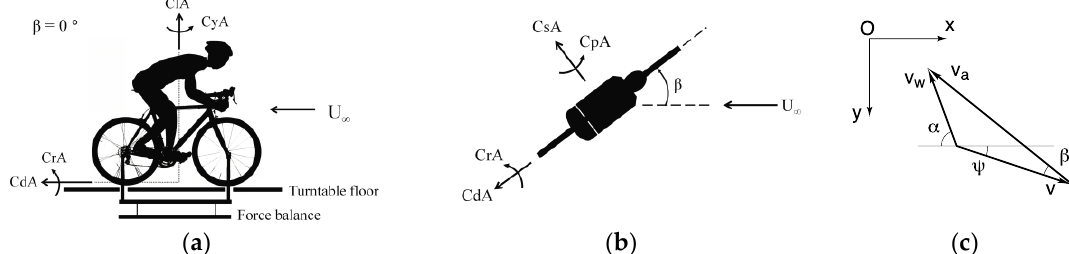
Figure 2. Bicycle and rider system subjected to cross wind together with the definition of the various aerodynamic force and moment coefficients and apparent wind speed, in ( a ) side view; and ( b ) top view, with drag force coefficient CdA , lift force coefficient ClA , side force coefficient CsA , roll moment coefficient CrA , pitch moment coefficient CpA , and yaw moment coefficient CyA ; ( a , b ) from Fintelman et al. [11]; and ( c ) absolute wind speed v w at an angle α, forward speed of the bicycle v at a heading ψ , and apparent wind speed v a at an apparent angle β relative to the bicycle